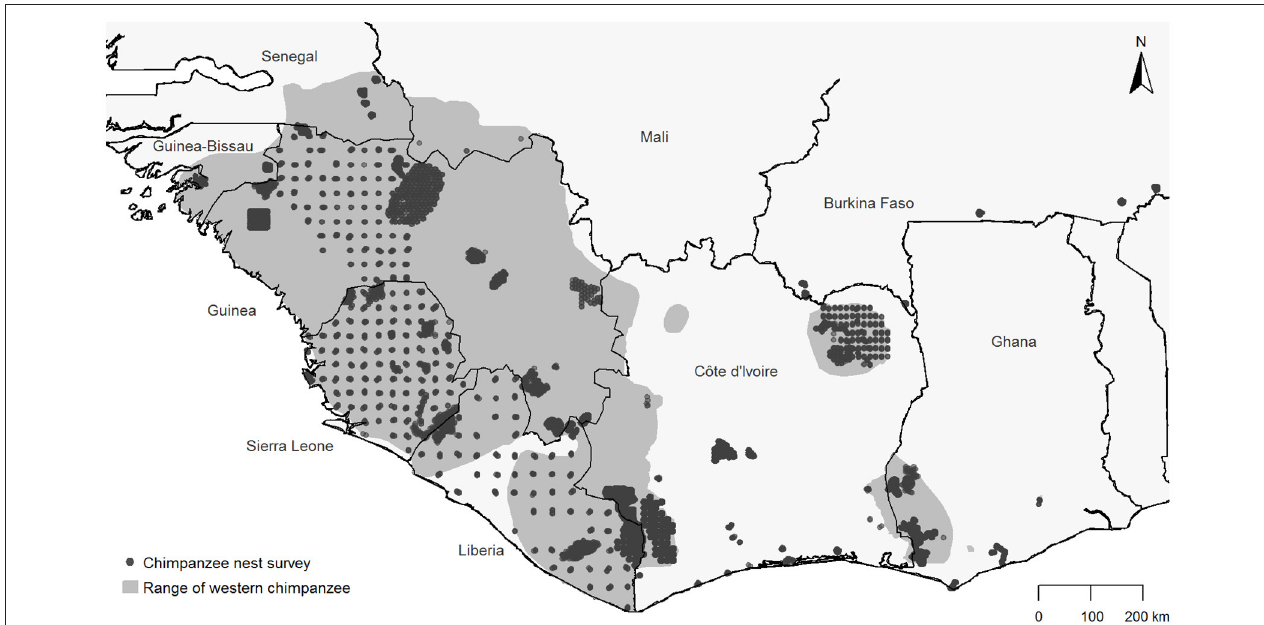
FIGURE 1 | Location of the 52 chimpanzee nest surveys compiled for this study and the geographic range of western chimpanzees (Humle et al.,